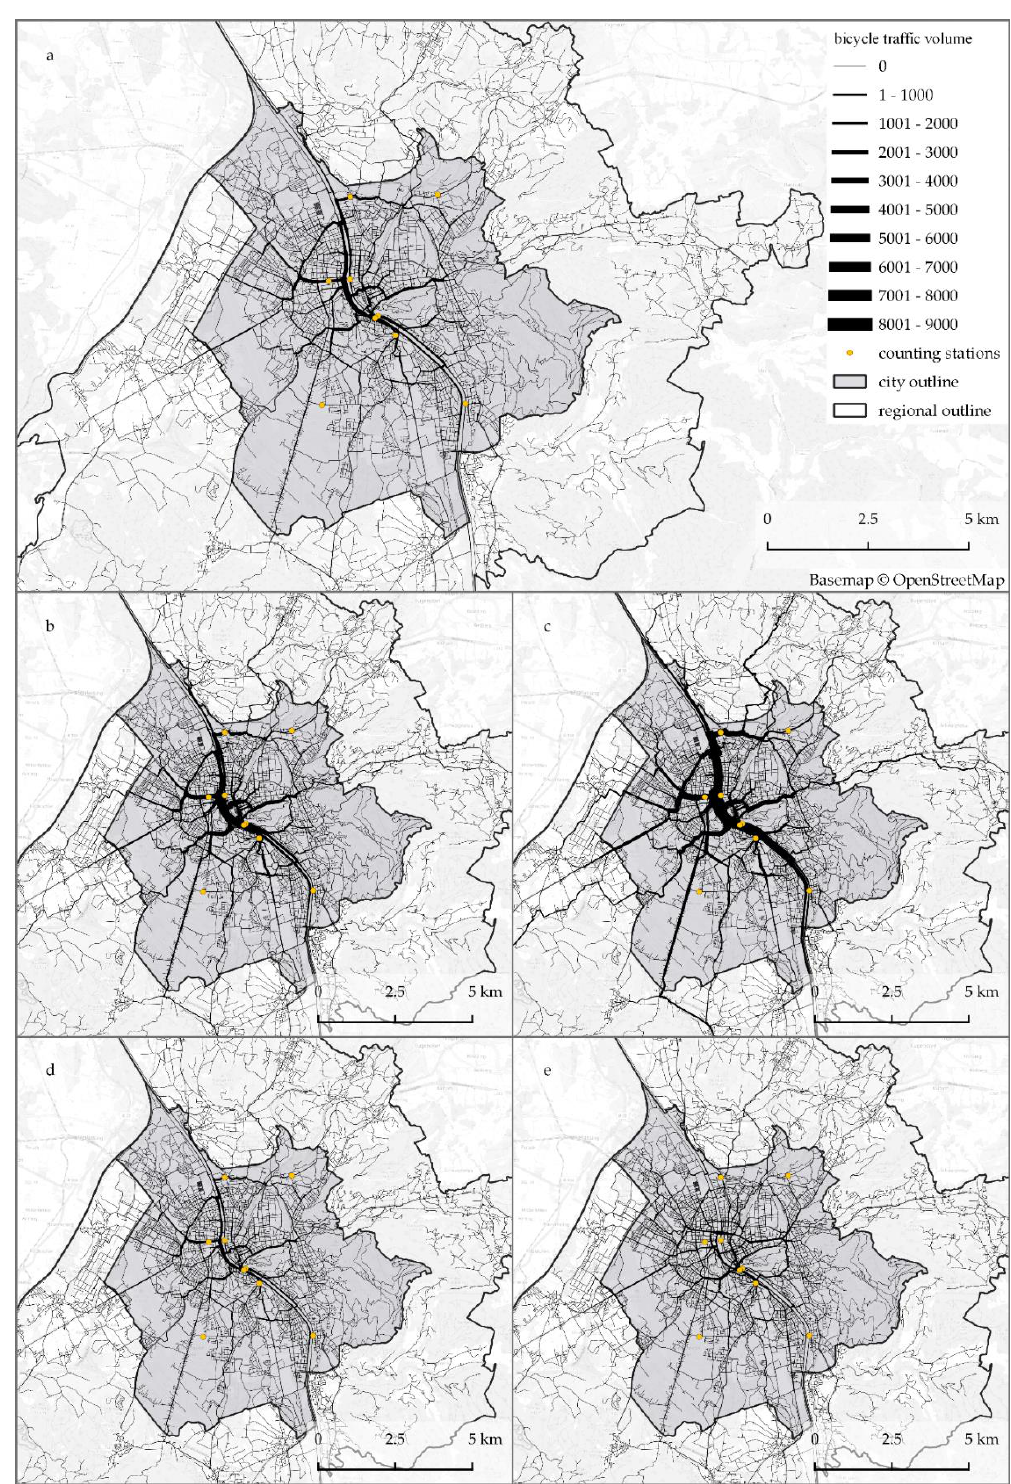
Figure 4. Bicycle traffic volumes of one simulation day in scenarios: ( a ) reference; ( b ) activity type choice; ( c ) target location choice; ( d ) starting time choice; ( e ) route